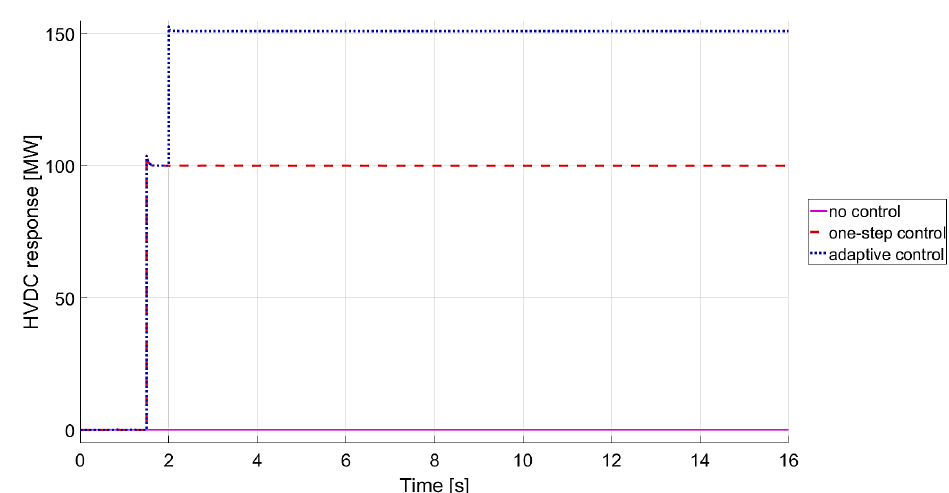
Figure 19. Frequency at bus 39 in Configuration II in case of small